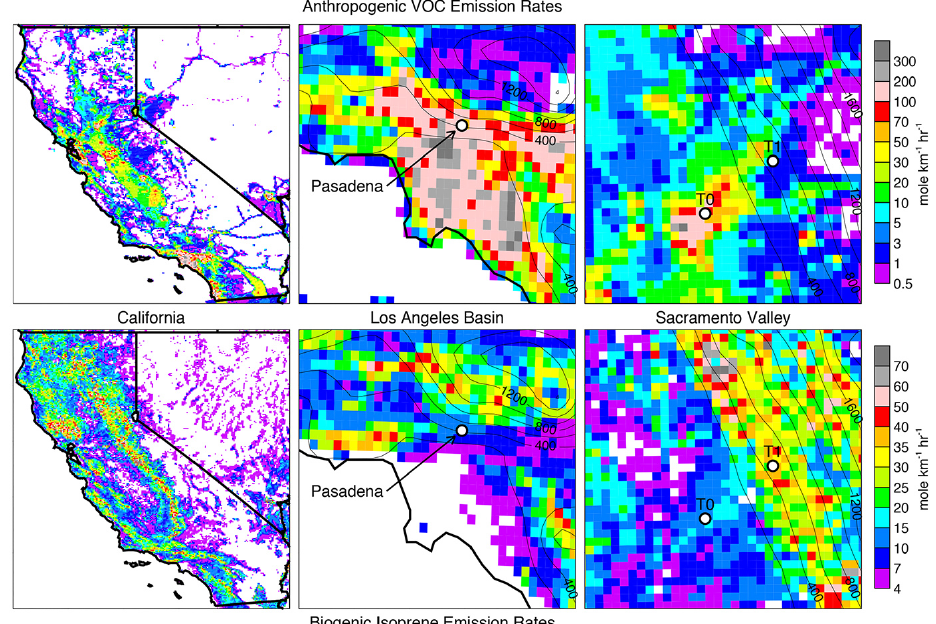
Figure 2. Spatial distribution of anthropogenic volatile organic compounds (VOC) (top) and biogenic isoprene (bottom) emission rates for a representative day at 10:00LST over California and in the vicinity of the Pasadena, T0, and T1 supersites (white dots). The middle panels depict the Los Angeles Basin and the right panels depict a portion of the Sacramento Valley. Contours denote model topography (m) and regions that are not shaded denote low emission